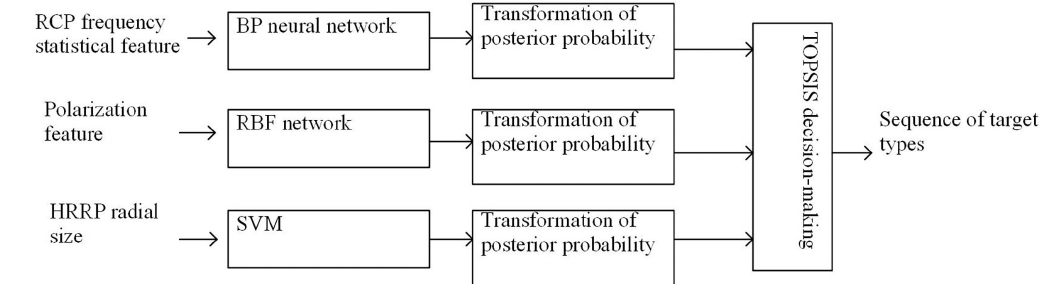
Fig. 2 Principle diagram of TOPSIS selection method with support of recognition posterior probability. TOPSIS, technique for order preference by similarity to ideal solution Step 1. Select the suitable classifier based on different target features for the target recognition, and obtain the respective recognition